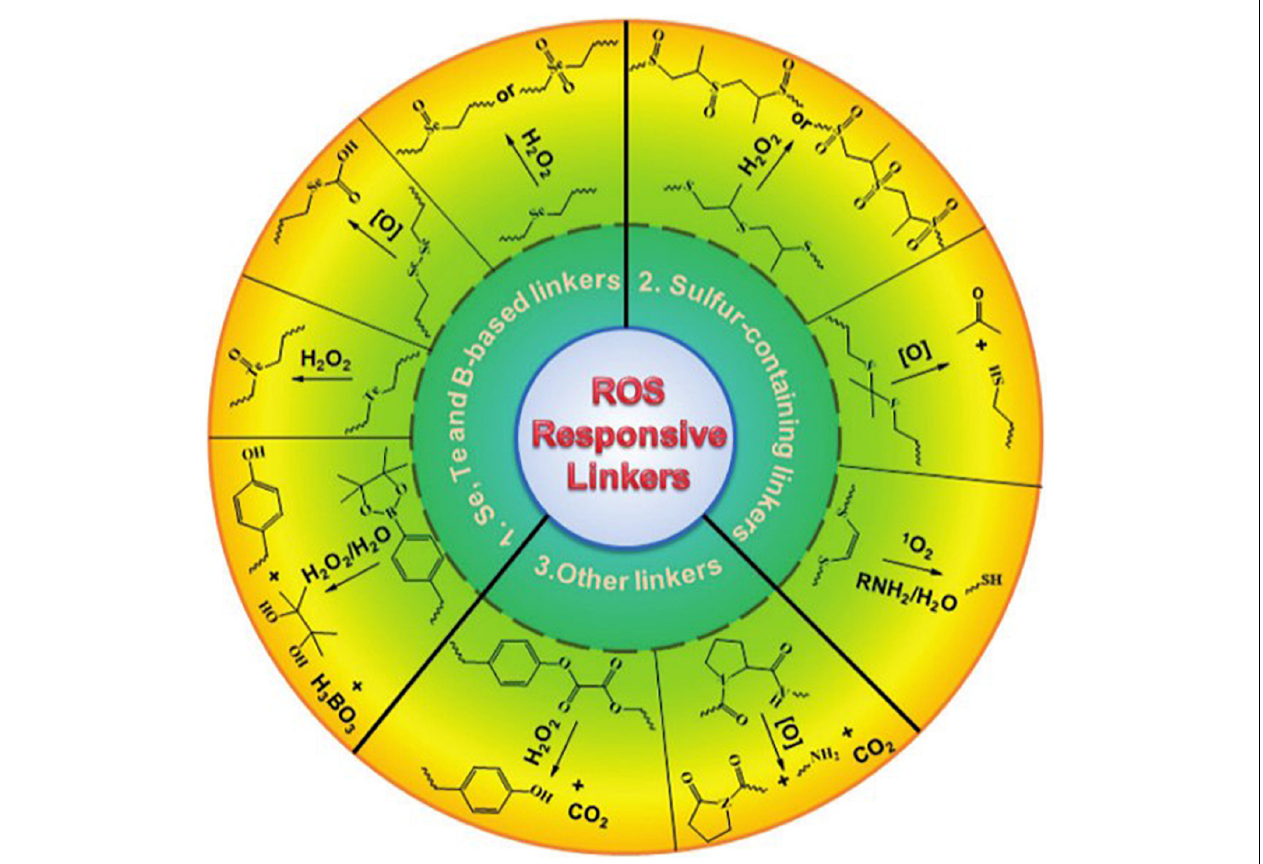
FIGURE 9 | Representative ROS-responsive linkers that have employed for the design of ROS-responsive drug carriers. Printed with permission from Willey (19). Copyright